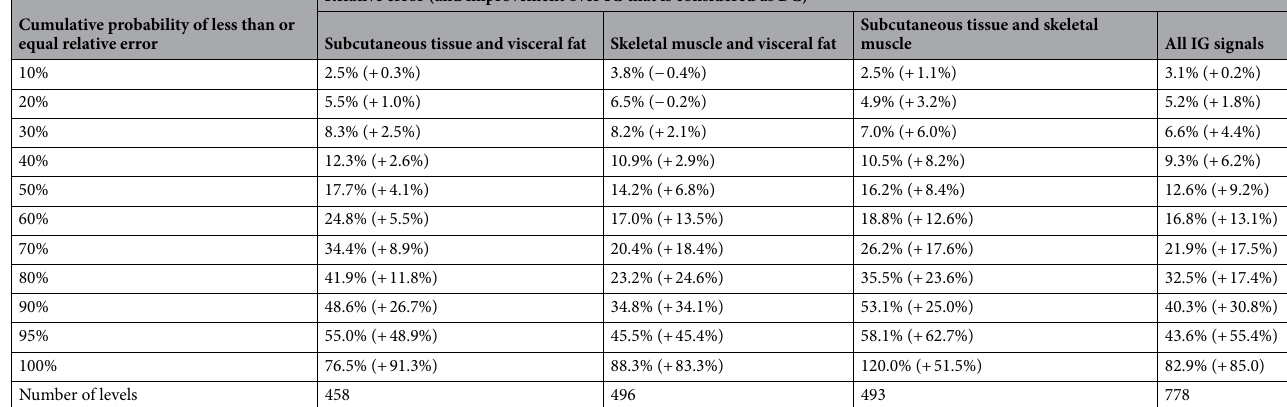
Table 4. Scenario d), calculated single BG using multiple IG signals and personalized parameters that were determined from IG signals